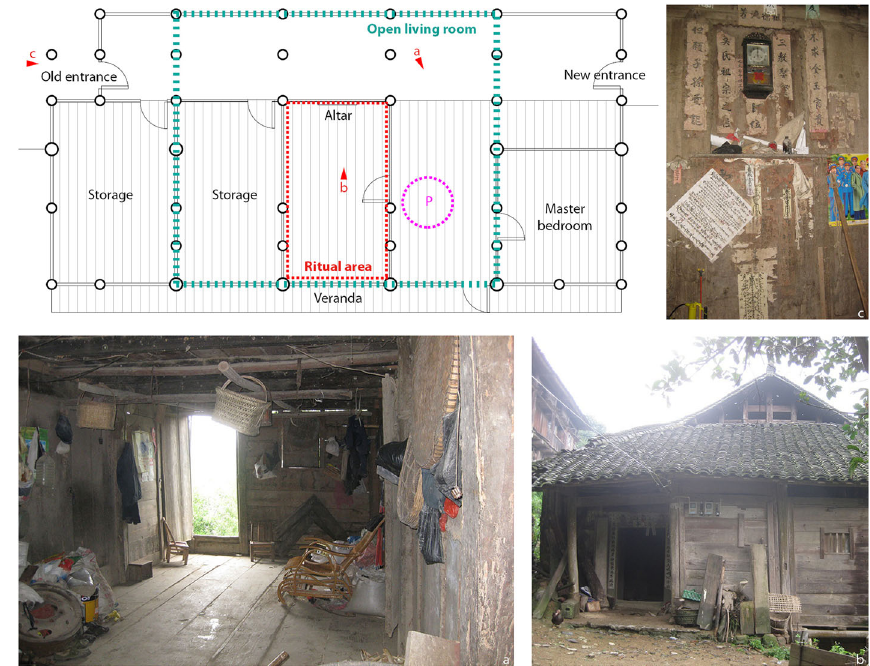
Fig. 13 The floor plan and photos of S6 show the P area (photo a) and rear entrance (photo b), which are similar to type A. The ritual area (photo c) and open living room divided into four parts are similar to type B (Source: the